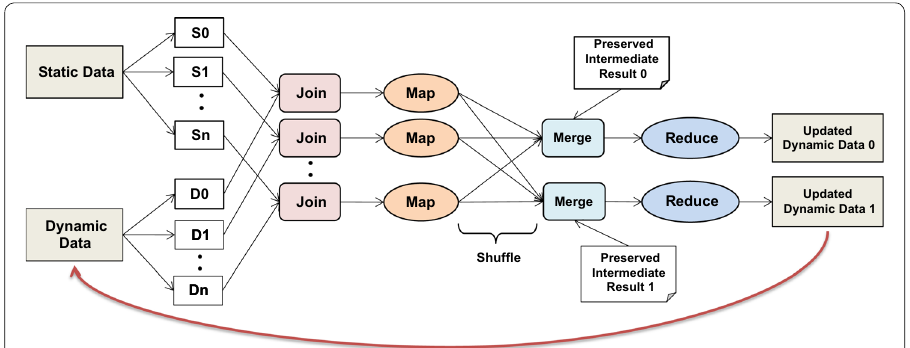
Fig. 1 Dataflow in incremental